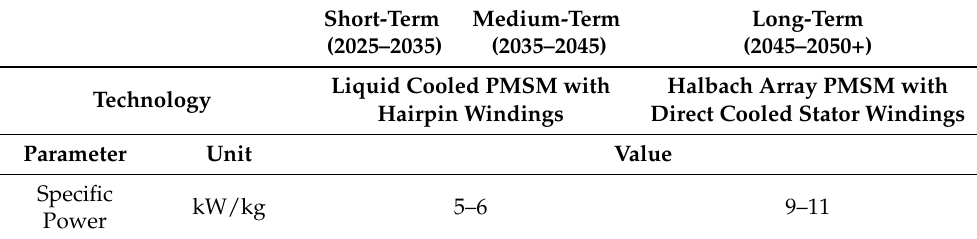
Table 3. Technology characteristics of electric machines.